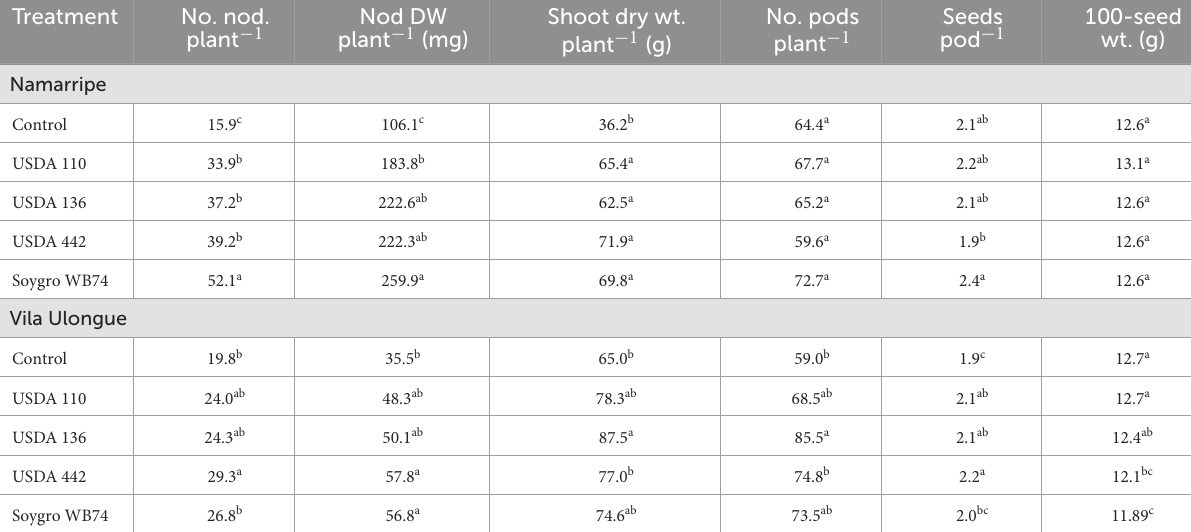
TABLE 3 Effects of inoculation on number and dry weight of nodules, shoot dry weight at R3 stage, number of pods, seeds per pod and 100-seed weight at Namarripe and Vila Ulongué, in 2018/2019 cropping season.